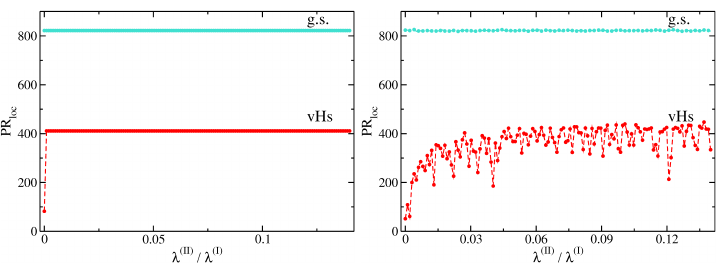
Figure 12. Evolution of the participation ratio PR loc ( E ) for the ground state (g.s.) and the most localized state at the van Hove singularity (vHs) in a 42 × 42 square lattice as a function of λ ( II ) / λ ( I ) . The case of no noise ( left ), corresponding to situations shown in Figure 3, is compared to weak noise affecting ( n ) | ≤ 10 − 2 ( right λ ( I ) and λ ( II ) , with relative strength | δ ij